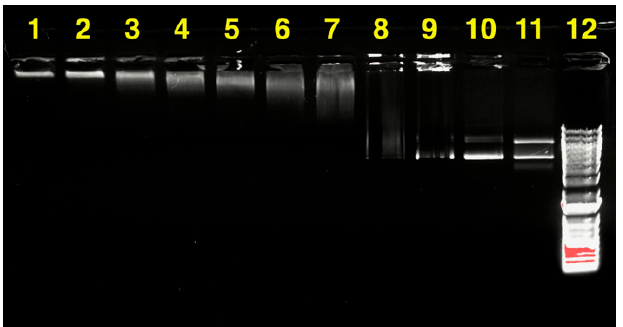
Figure 13. pDNA release from PEG- b -CPCL-70:pDNA nanocomplexes at a 200:1 mass ratio (N/P = 142) by increasing polyanionic heparin. The nanocomplexes were incubated for 1 h at 37 °C with different amounts of heparin. (1)–(10) nanocomplex:heparin at mass ratios of (1) 1:0, (2) 1:0.001, (3) 1:0.002, (4) 1:0.004 (5) 1:0.006, (6) 1:0.008, and (7) 1:0.01, (8) 1:0.02, (9) 1:0.04, (10) 1:0.06, (11) pDNA, and (12) MW marker (DNA ladder).